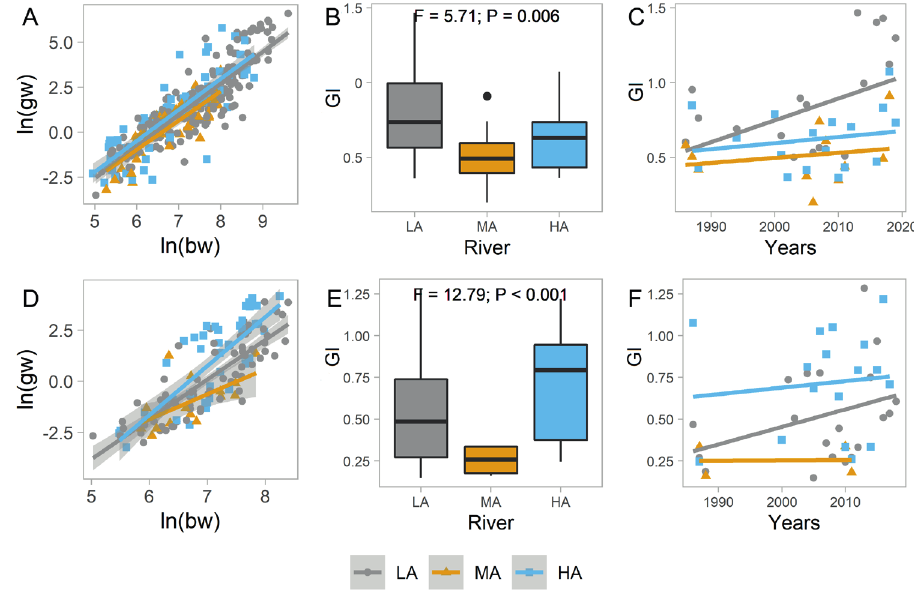
FIGURE 5 | ANCOVA interaction effects for the relationship between gonad weight (gw) and body weight (bw) for female ( A ) and male ( D ) Salminus brasiliensis . Mean gonadal index (GI) for female ( B ) and male ( E ) S. brasiliensis by river (HA – highly altered; MA – moderately altered; LA – less altered). GI for female ( C ) and male ( F ) S. brasiliensis over time. GI was measured as the relationship between ln(gw)/ln(bw^1.25) for females and ln(gw)/ln(bw^1.07) for